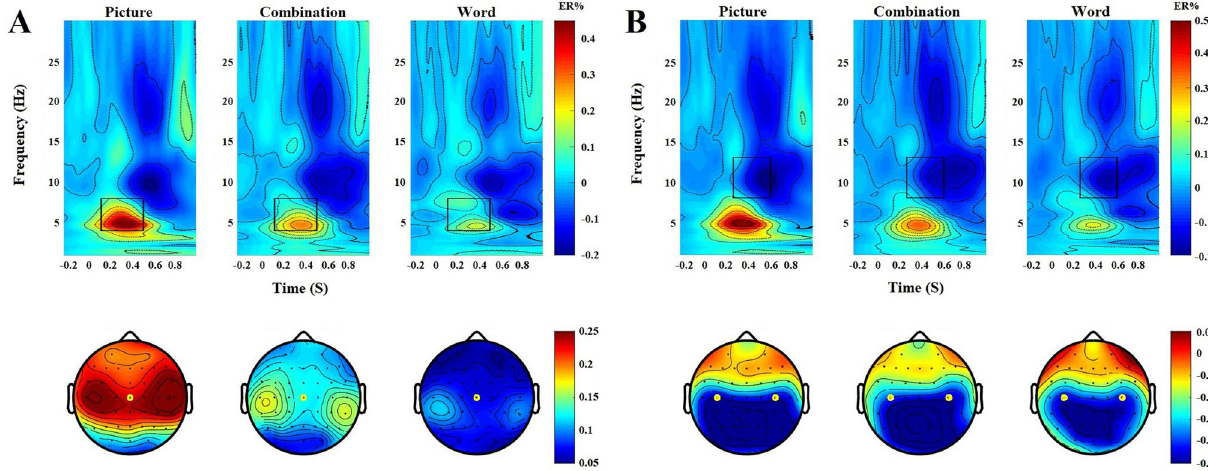
Figure 5. Difference oscillation in the oddball task: ( A ) time–frequency of theta band; ( B ) time–frequency of mu band. Rectangular areas are the range of time and frequency of the theta band and the mu band